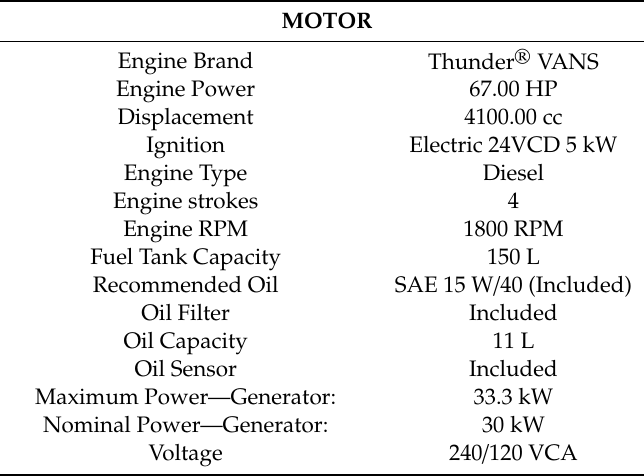
Table 2. Technical characteristics of the electric generator.